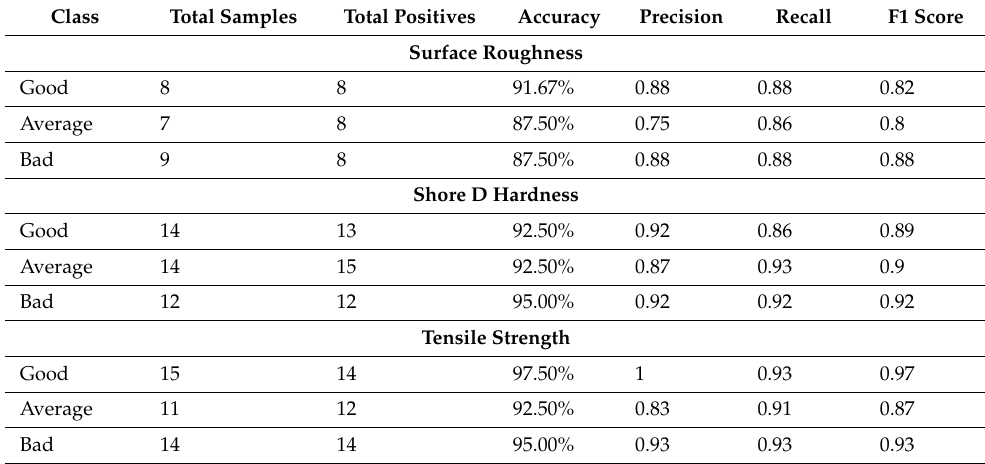
Table 10. Confusion matrix analysis of the random forest classifier for surface roughness, hardness, and tensile